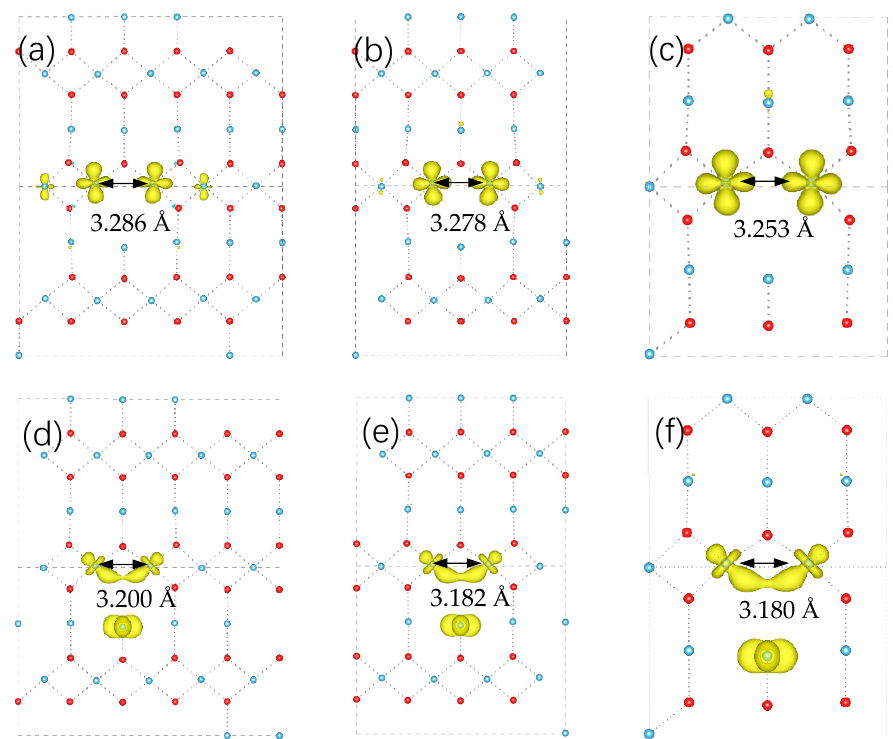
Figure 3. Polaronic structure of oxygen vacancy with different size of supercell. ( a , d ) for 3 × 3 × 5 supercell, ( b , e ) for supercell 3 × 3 × 4, ( c , f ) for 2 × 2 × 3 supercell. In all of the configurations, the distances between two equatorial Ti atoms get shorter with gradually decreasing the size of supercell along c axis.